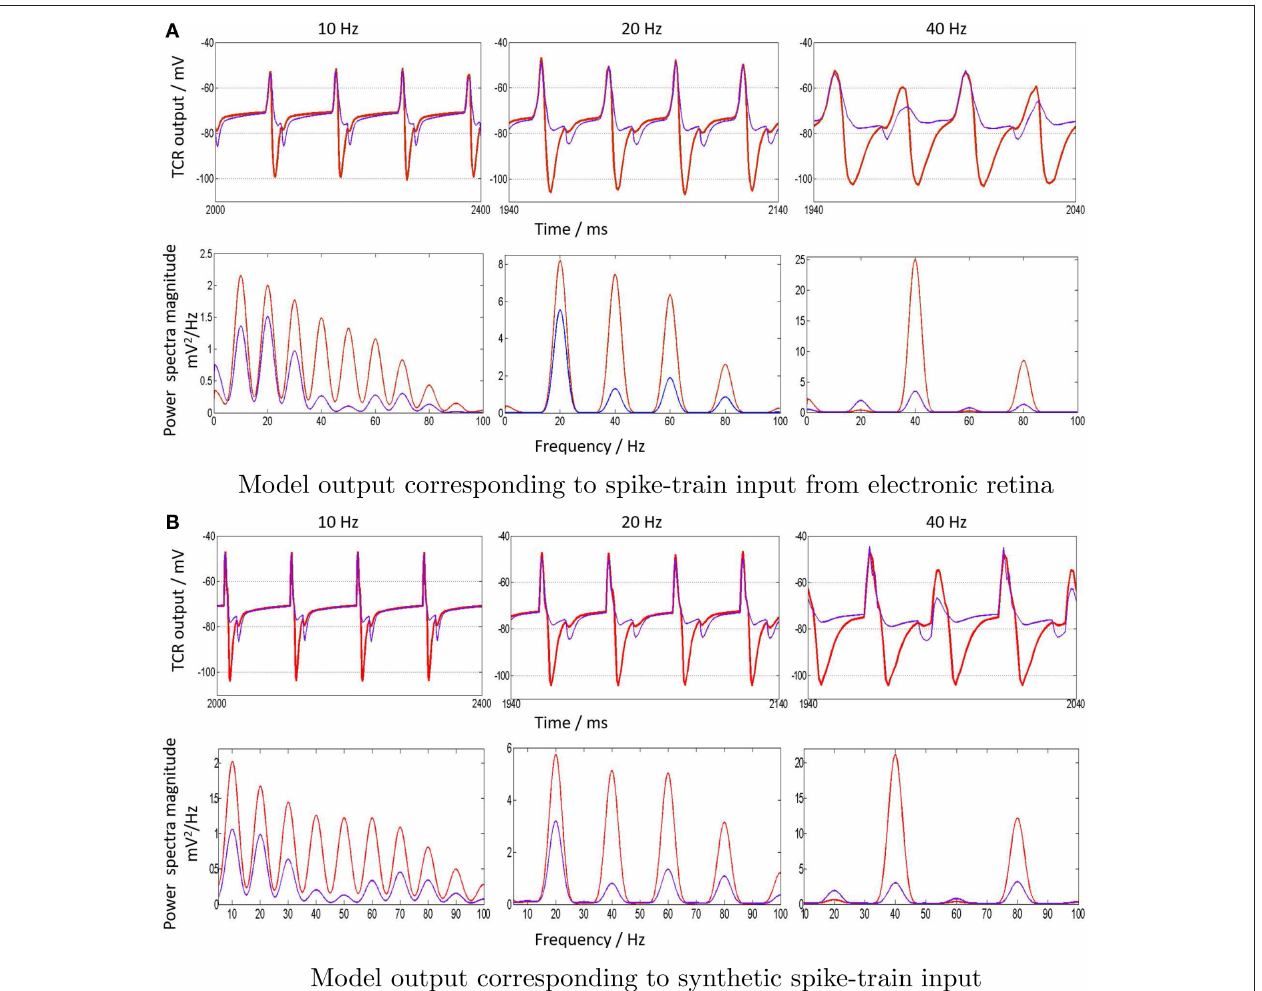
FIGURE 7 | (A) “Zoomed-in” plots (red) of the model output time-series (top row) and corresponding power spectra (bottom row) in response to spike-train inputs generated by the electronic retina when subjected to periodic visual stimulation at 10, 20, and 40Hz. The input frequencies are chosen as representative samples of upper-alpha (10–13Hz), beta (14–30Hz) and gamma ( > 30Hz) EEG frequency bands that are associated with cognitive brain states. A comparative study, when the IN inhibition is suppressed in the LGN model with a simultaneous dominance of the TRN inhibition, is also indicated (blue) for all cases. (B) To validate the model output corresponding to synthetic periodic input stimulus generated in PyNN with the results in (a), the “zoomed in” time-series and power spectral density for 10, 20, and 40Hz are shown. Both cases of when the IN is dominant (red) and suppressed (blue) are also